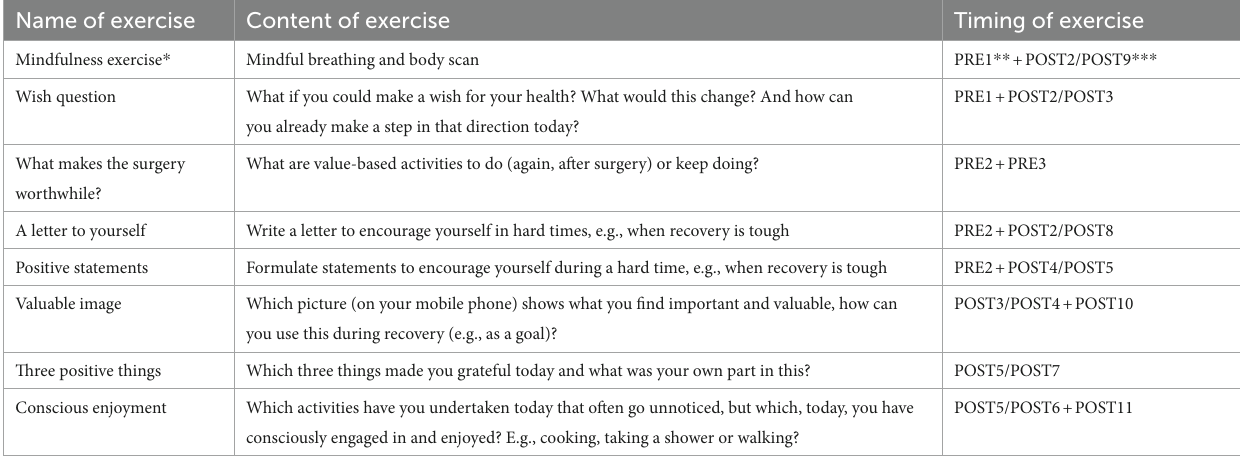
TABLE 3 Overview of positive psychology and ACT exercises in the intervention Strength Back. Name of exercise Content of exercise Timing of